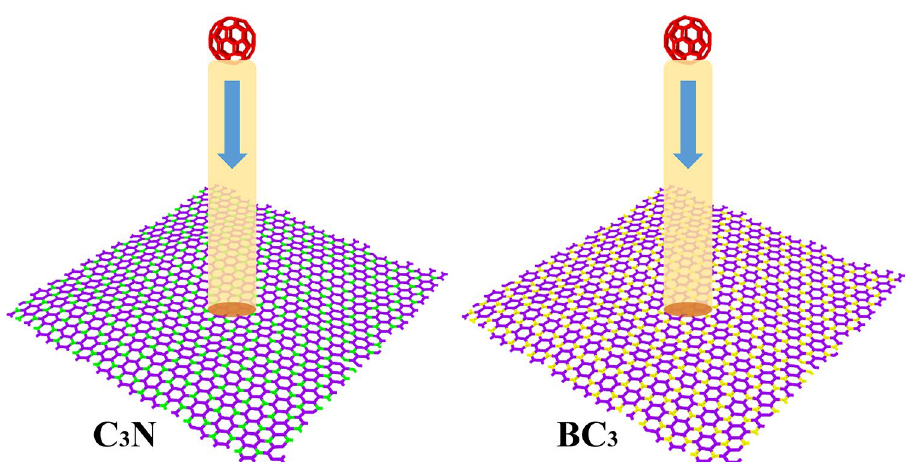
Figure 1. The C 3 N (left) and BC 3 (right) atomic configuration with a honeycomb structure includes carbon– nitrogen and carbon-boron atoms, respectively. The red bonds show the structure of the fullerene molecule. In their ideal structures, each boron and nitrogen atom is surrounded by three carbon atoms. Carbon, nitrogen, and boron atoms are presented respectively in purple, green, and